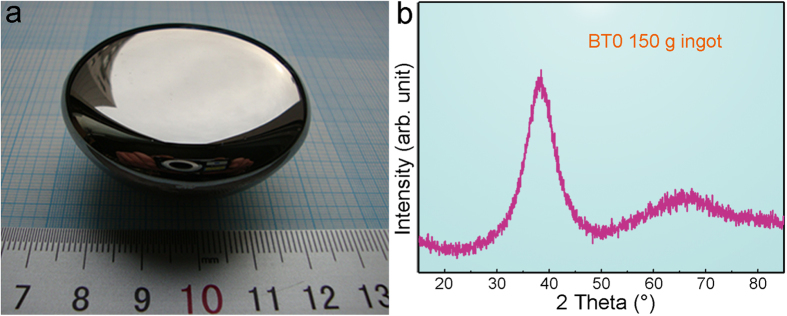
The as-solidified 150 g ingot.(a) The appearance of the 150 g ingot of Ti32.02Zr30.13Cu9.01Co4.84Be24.00 (at.%, BT0). The mirror-like surface and the diffraction humps in its X-ray diffraction pattern (b) indicate that it is fully amorphous.